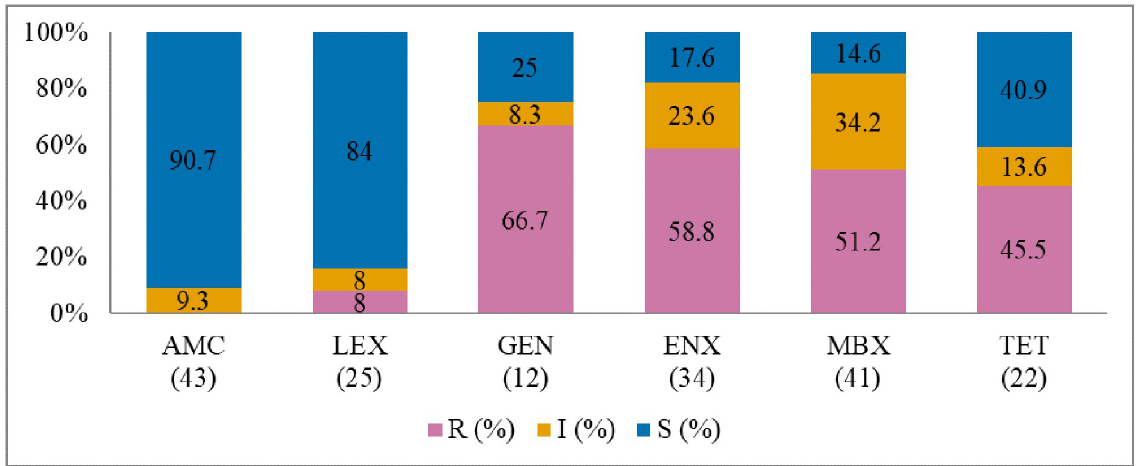
Fig 4. Antibiotic susceptibility pattern from Streptococcus canis isolates from diseased cats (January 2015–December 2017). R–resistance; I-intermediate; S–susceptible; AMC–amoxicillin/clavulanic acid; LEX–cephalexin; GEN–gentamicin; ENX–enrofloxacin; MBX– marbofloxacin; TET–tetracycline. Numbers inside brackets ‘()’ indicate the total number of tested isolates for each